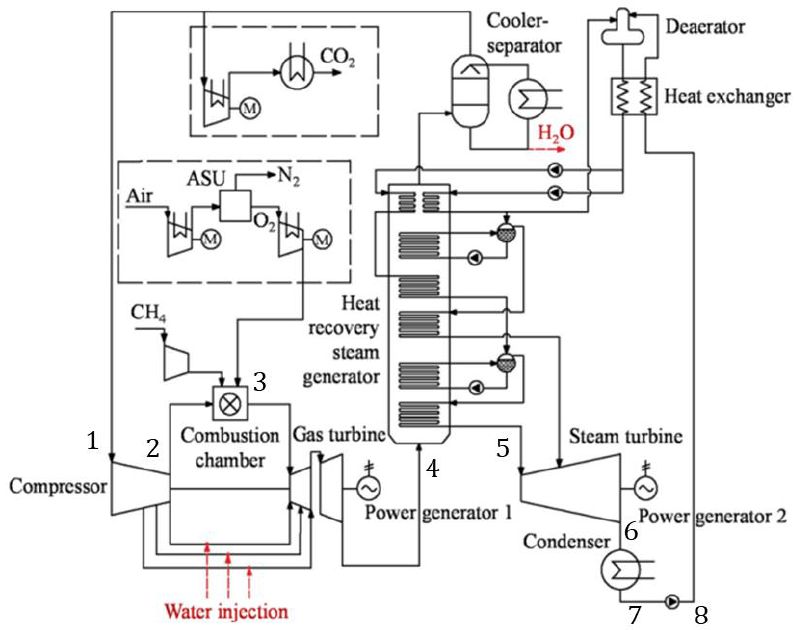
Figure 22. Schematic diagram of SCOC-CC cycle with water injection [38]. ASU—air separation